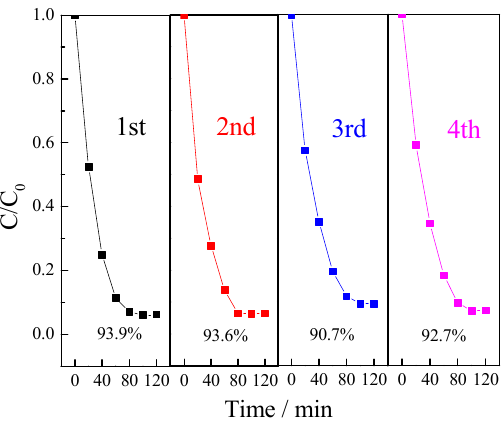
Figure 10. Recycle runs in the photocatalytic degradation of benzohydroxamic acid by La/TiO 2 . Reaction conditions: C (benzohydroxamic acid) = 30 mg·L − 1 , C (catalyst dosage) = 0.5 g·L − 1 , 300 W mercury lamp, 0.75% La/TiO 2 , calcined temperature at 500 °C.